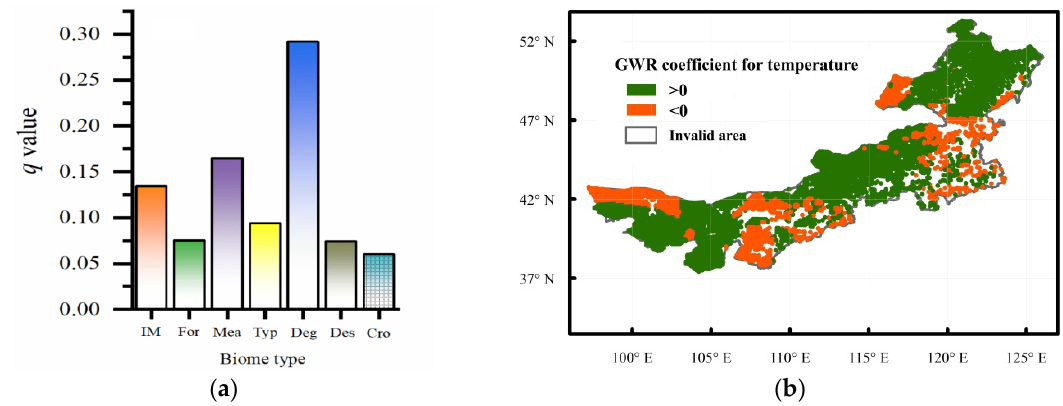
Figure 5. Relationships between the CVs of the growing season temperature and those of the NDVI in Inner Mongolia during 1982–2015: ( a ) forest, ( b ) meadow steppe, ( c ) typical steppe, ( d ) desert steppe, ( e ) desert, and ( f ) crop.